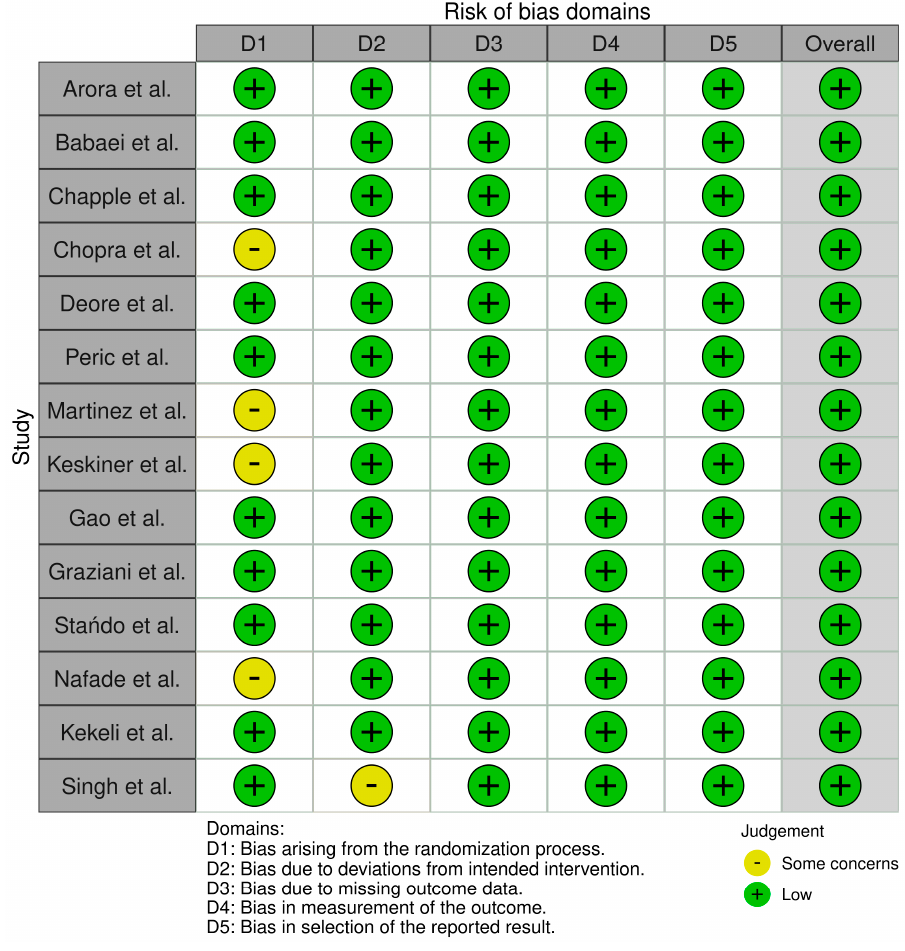
Figure 2. Risk of Bias analysis according to RoB 2: Domains.